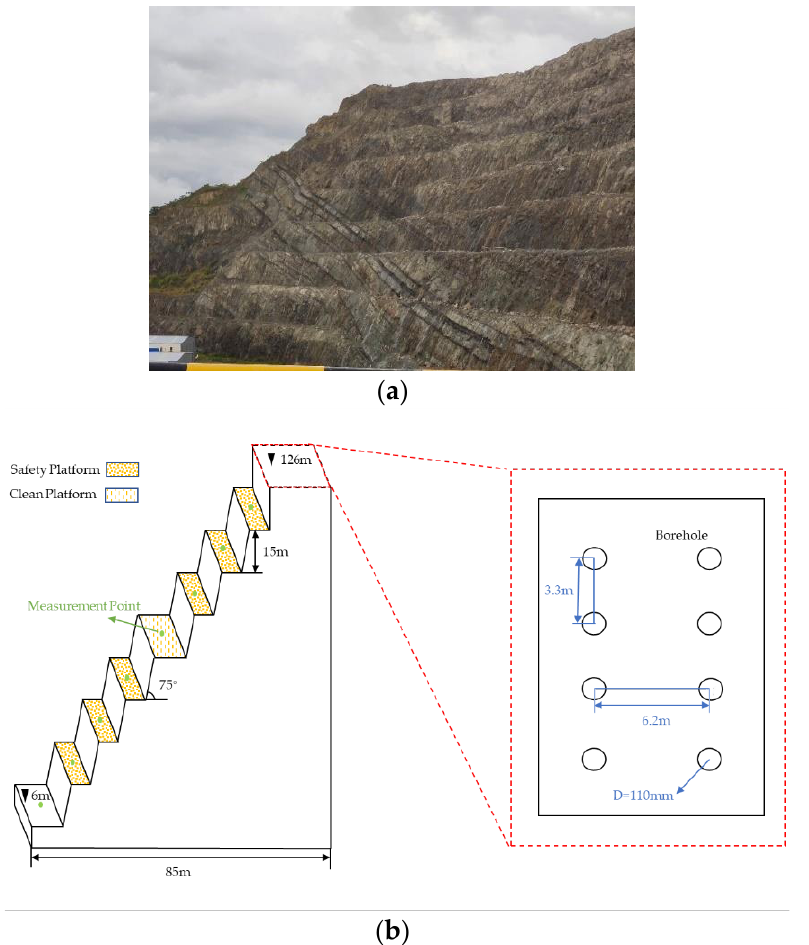
Figure 5. Schematic diagram of the scene and the corresponding model: ( a ) Site map of the slope; ( b ) Schematic diagram of the model.